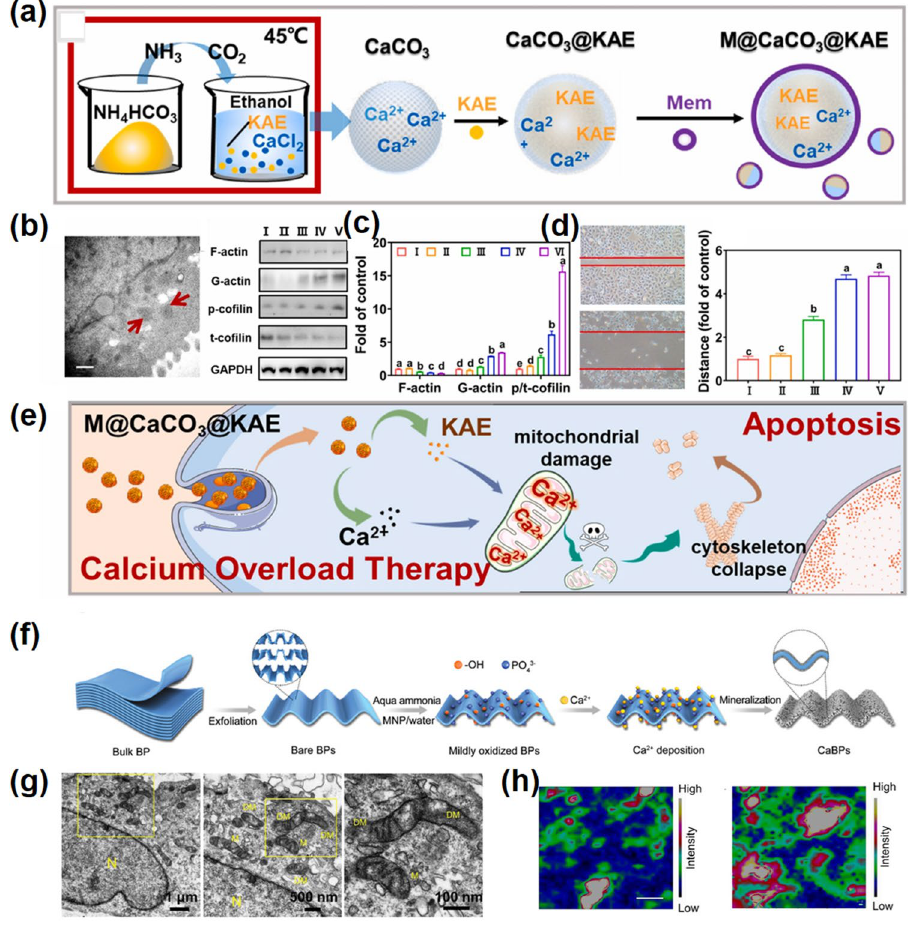
Fig. 8 Ca-NMs mediated ion interference therapy. a Illustration of the preparation process of M@CaCO 3 @KAE NPs. b TEM image of mito- chondria after M@CaCO 3 @KAE NPs treatment. c Protein levels (left panel) and the intensity (right panel) of A549 cells. d Migration ability (left panel) and the quantitative results of migration distance (right panel) of A549 cells. e Schematic diagram of M@CaCO 3 @KAE NP-medi- ated apoptosis [42]. Copyright 2021, Elsevier. f Synthetic process of CaBPs. g Bio-TEM images of in CaBPs treatment group, where N repre- sents the nucleus, M represents the healthy mitochondria, and DM represents the damaged mitochondria. h Raman mapping of